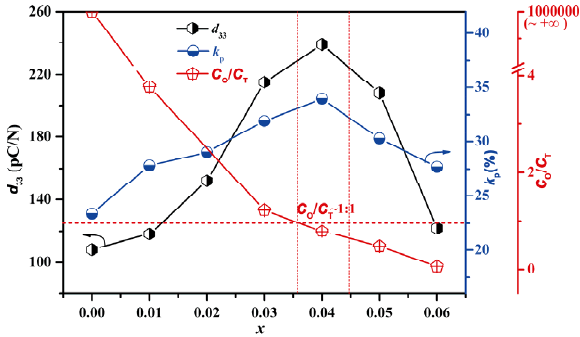
Fig. 6 Piezoelectric coefficient ( ), electromechanical coupling factor ( ceramics.